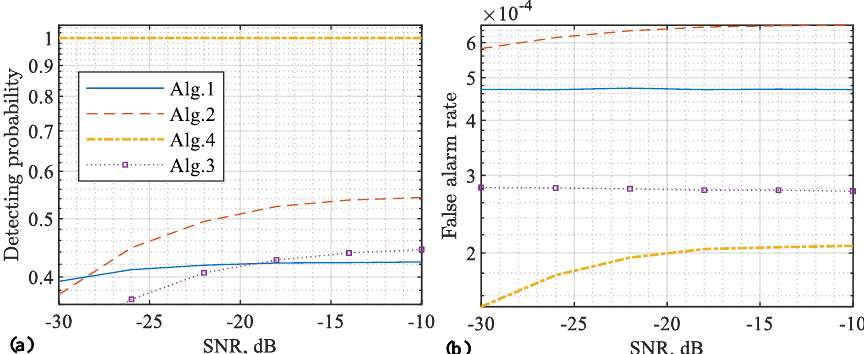
Figure 9. Detecting performance versus SNR (with respect to y ), where four targets are set with randomly generated parameters over 10 4 independent trials. The detecting probability is given in ( a ) and the false alarm rate is given in ( b ). Please note that the symbol “-” before all numbers, as automatically generated by MATLAB during plotting the figure, denotes the negative sign.